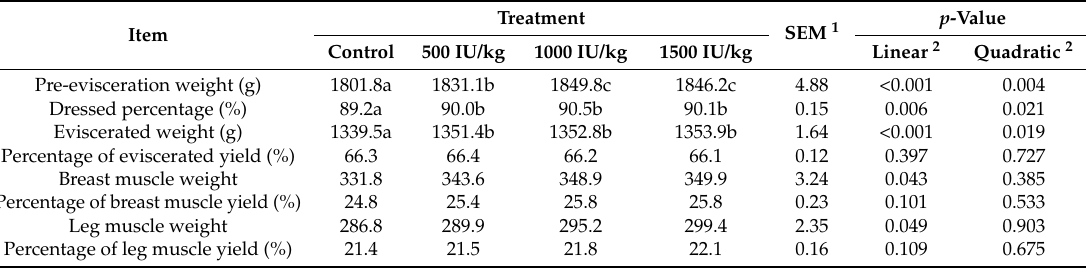
Table 2. Effects of dietary optiXynB on carcass characteristics of